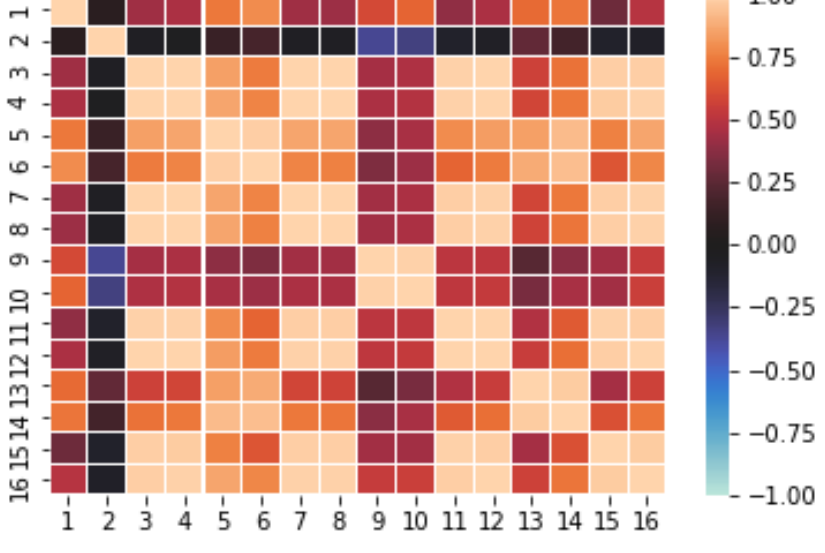
Figure 5. Correlation matrix for the 16 sensors in the [39] dataset. Warm colors (with maximum light orange) stand for strong positive correlation and cool colors (with maximum light blue) mean strong negative correlation. Black indicates no linear